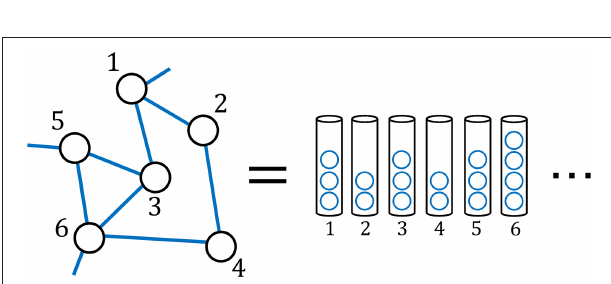
FIGURE 6 | An example of equivalence between a networks and the urns containing balls.